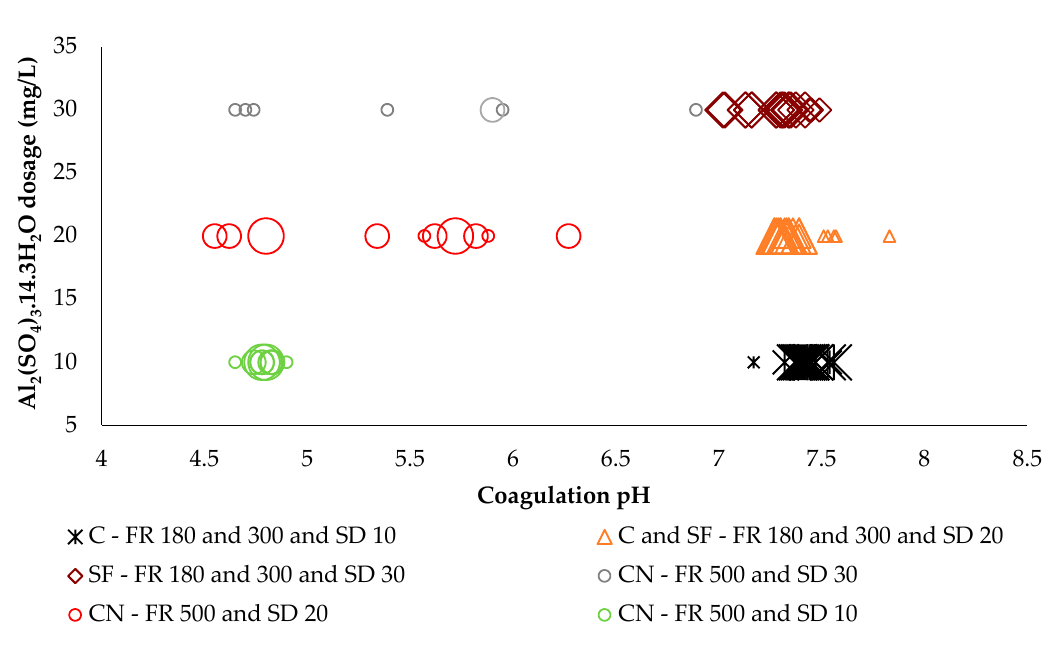
Figure 8. Coagulation diagram with remaining turbidity points for coagulation pH levels and aluminium sulfate dosage—pilot Water Treatment Plant. Smaller symbols: remaining turbidity > 0.5 NTU, intermediate size symbols: remaining turbidity between 0.25 NTU and 0.5 NTU and larger symbols: remaining turbidity < 0.25 NTU.